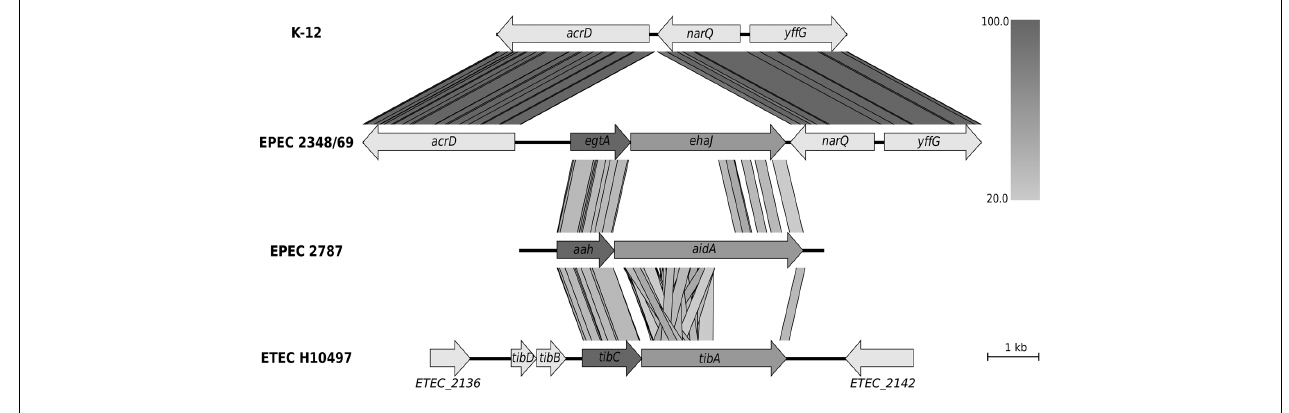
autotransporter gene is conserved, the genomic positions of these two genes are different in the four genomes.The figure was generated using Easyfig (http://easyfig.sourceforge.net/; Sullivan et al., 2011) with amino acid sequence comparison (tBLASTx).The level of amino acid identity is shown in the gradient